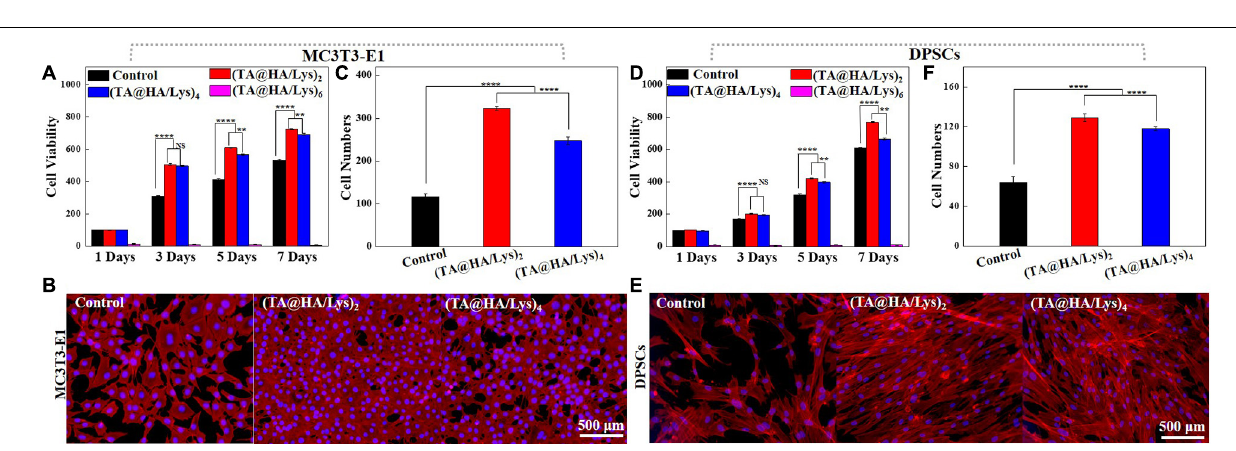
FIGURE 4 | (A) Cell viability of mouse embryo osteoblast precursor cells (MC3T3-E1) cultured onto control, (TA@HA/Lys) 2 , (TA@HA/Lys) 4 , and (TA@HA/Lys) 6 at 1, 3, 5, and 7 days. (B) Fluorescence images and (C) cell numbers of MC3T3-E1 cells cultured onto control, (TA@HA/Lys) 2 , (TA@HA/Lys) 4 , and (TA@HA/Lys) 6 at day 5. (D) Cell viability of dental pulp stem cells (DPSCs) cultured onto control, (TA@HA/Lys) 2 , (TA@HA/Lys) 4 , and (TA@HA/Lys) 6 at 1, 3, 5, and 7 days. (E) Fluorescence images and (F) cell numbers of DPSCs cultured onto control, (TA@HA/Lys) 2 and (TA@HA/Lys) 4 at day 5. All images were using the same scale bar. ** p < 0.01, **** p <